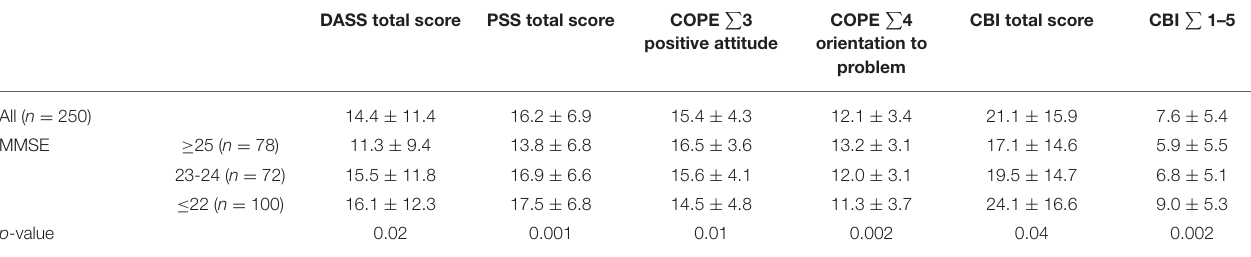
TABLE 2 | Psychological well-being and coping strategies scales in the total sample and by pre-quarantine cognitive functioning.